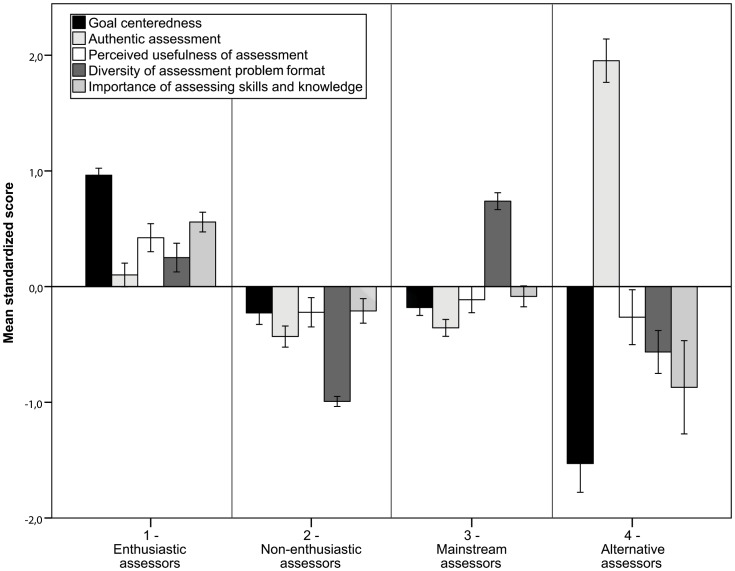
Mean standardized scores on factors for teachers in the four latent classes.
Note. Whiskers indicate 95% confidence interval.